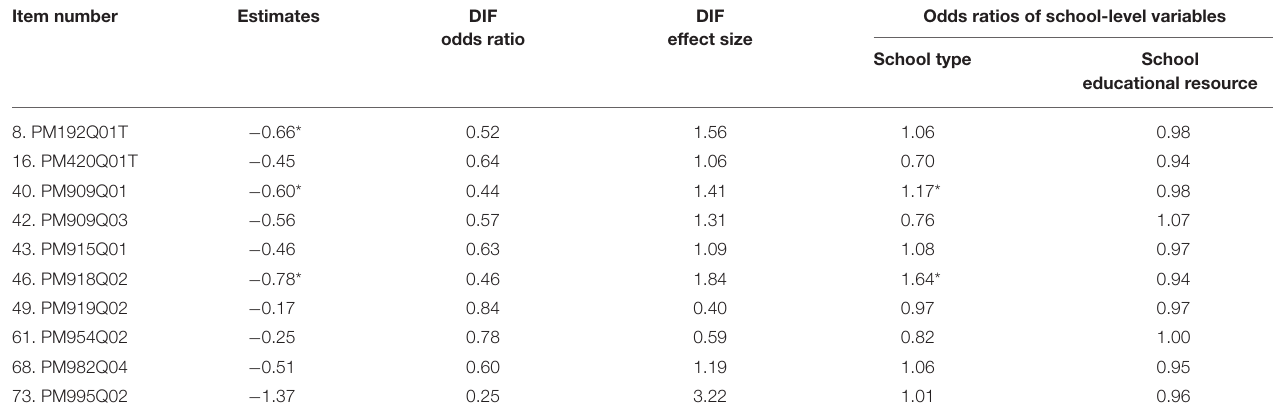
TABLE 6 | Summary of results from HGLM Model 3.